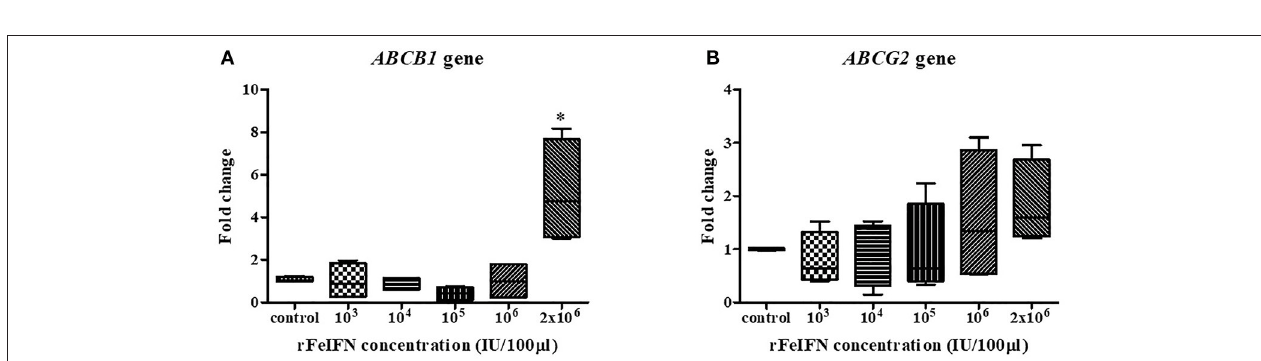
FIGURE 2 | Box plot showed the relative mRNA expression of BCL-2 (A) , BAX (B) gene, and the relative BCL-2 / BAX ratio (C) of primary CTVT culture at 72-h after incubation with varied concentrations of rFeIFN- ω (* p < 0.05; *** p < 0.001).